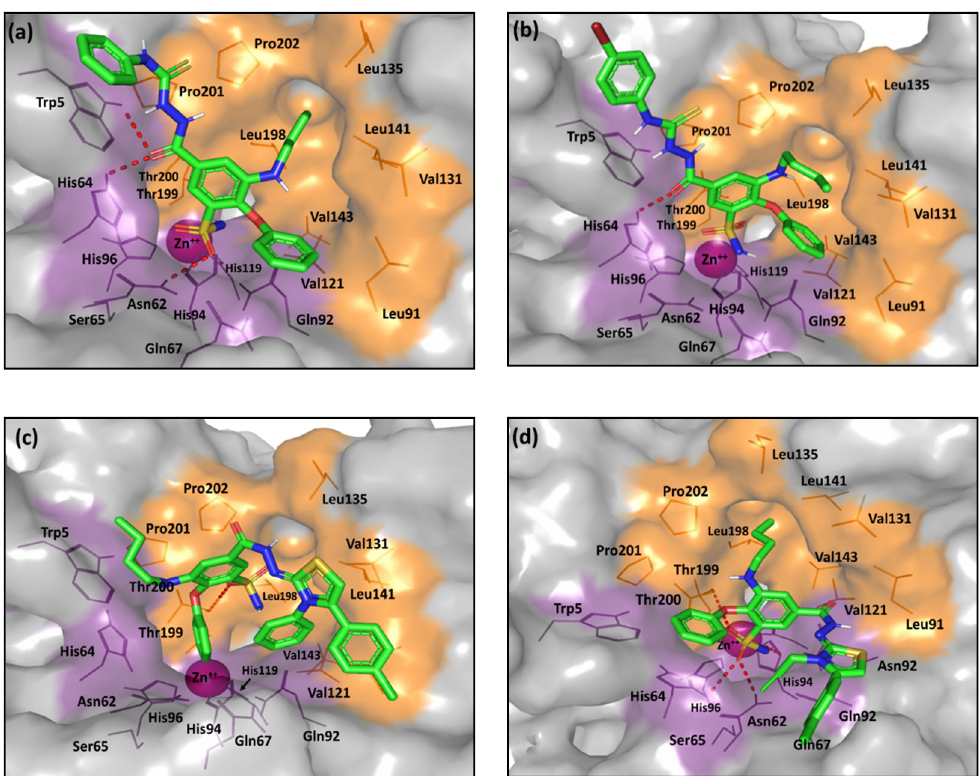
Figure 8. The predicted binding modes of the investigated compounds (sticks) at the h CA-IX binding site (PDB ID: 3iai); ( a ) 7a ; ( b ) 7c ; ( c ) 8a ; ( d ) 8d . The active site cleft within the suggested ligand-protein complexes is illustrated as gray surface representation depicting the prosthetic Zn(II) (magenta sphere), as well as the hydrophilic (purple) and hydrophobic (orange) residues as lines. Hydrogen bonding is depicted as red dashed-lines, while polar coordination to Zn(II) as black dashed-lines. Only residues located within 5 Å radius of bound ligands are displayed (lines) and labeled with sequence number.